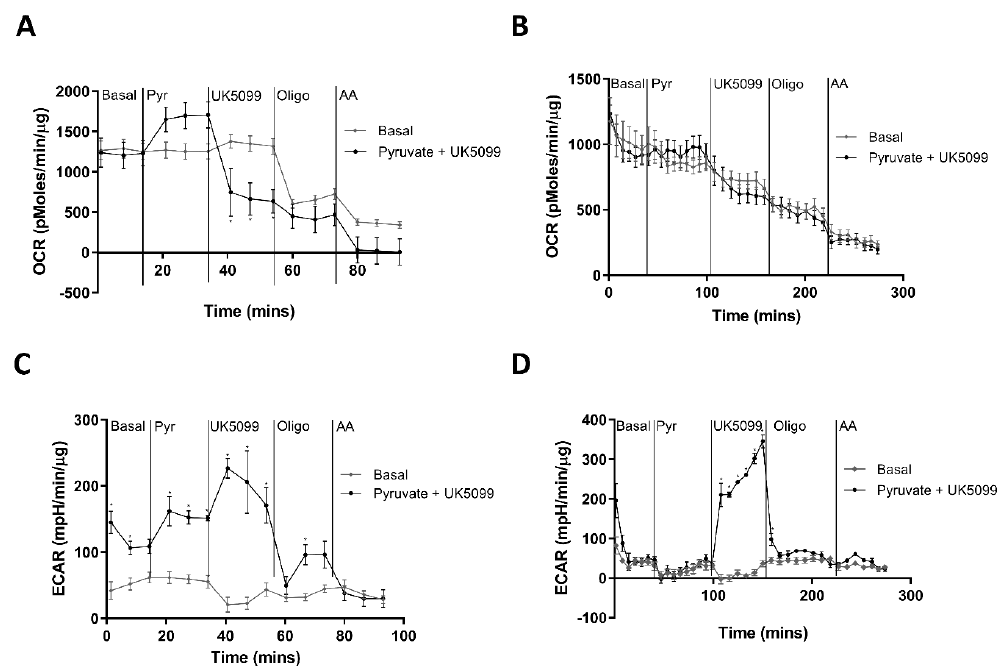
Figure 3. ECAR reflects changes in lactate production and mitochondrial metabolism. MIN6 cells (passage 26–29) were cultured in Seahorse 24-well plates for 5 days (ML) or un-coated Petri-dishes for 4 days before transfer to a 24-well islet capture plate for 24 h (PI). ( A – D ) The Oxygen Consumption Rate (OCR) and Extracellular Acidification Rate (ECAR) were measured using the Seahorse XFe24 well analyser with additions of either media only (Basal), Glucose (25 mM), Pyruvate (10 mM) at time point 1 followed by UK5099 (100 μ M) at time point 2, oligomycin (2 μ M for ML, 20 μ M for PI) at time point 3 and antimycin A (0.5 μ M) at time point 4, as indicated. ( A ) OCR for ML expressed as pmol/min/ μ g protein. ( B ) OCR for PI expressed as pmol/min/ μ g protein. ( C ) ECAR for ML expressed as mpH/min/ μ g protein. ( D ) ECAR for PI expressed as mpH/min/ μ g protein. n = 4. * p < 0.05 using a 2 ‐ way ANOVA followed by Bonferroni post hoc test. Whilst the MIN6 PI model is considered a good representation of pancreatic islets, its major limitation is the reliance on a clonal β‐ cells which differ from endogenous β‐ cells. We therefore determined the contribution of OCR and ECAR to the glucose responsive ‐ ness of isolated human islets. Glucose stimulation of human islets increased OCR (Figure 4A) and also markedly stimulated ECAR (Figure 4C). There was no effect of pyruvate on either parameter. Oligomycin treatment decreased both OCR and ECAR (Figure 4A,B), suggesting that the ECAR readout may represent both anaerobic glycolysis and changes in oxidative phosphorylation, given the high basal OCR. Calculation of ATP production from glycolytic vs. mitochondrial sources show that glucose induced a greater increase in ATP production from glycolysis (Figure 4D) vs. mitochondrial metabolism (Figure 4B), with no response to pyruvate. Combining the ATP production from OCR and glycolysis, human islets showed good glucose responsiveness (Figure 4E,F). Although this is similar to the MIN6 PI model, it should be noted that glucose ‐ stimulated ECAR was lower in magnitude in human islets compared to MIN6 PI (7.0 ± 1.9 ‐ fold vs. 33.8 ± 5.9 ‐ fold) despite similar increases in the OCR (2.1 ± 0.3 ‐ fold vs. 2.2 ± 0.3 ‐ fold).